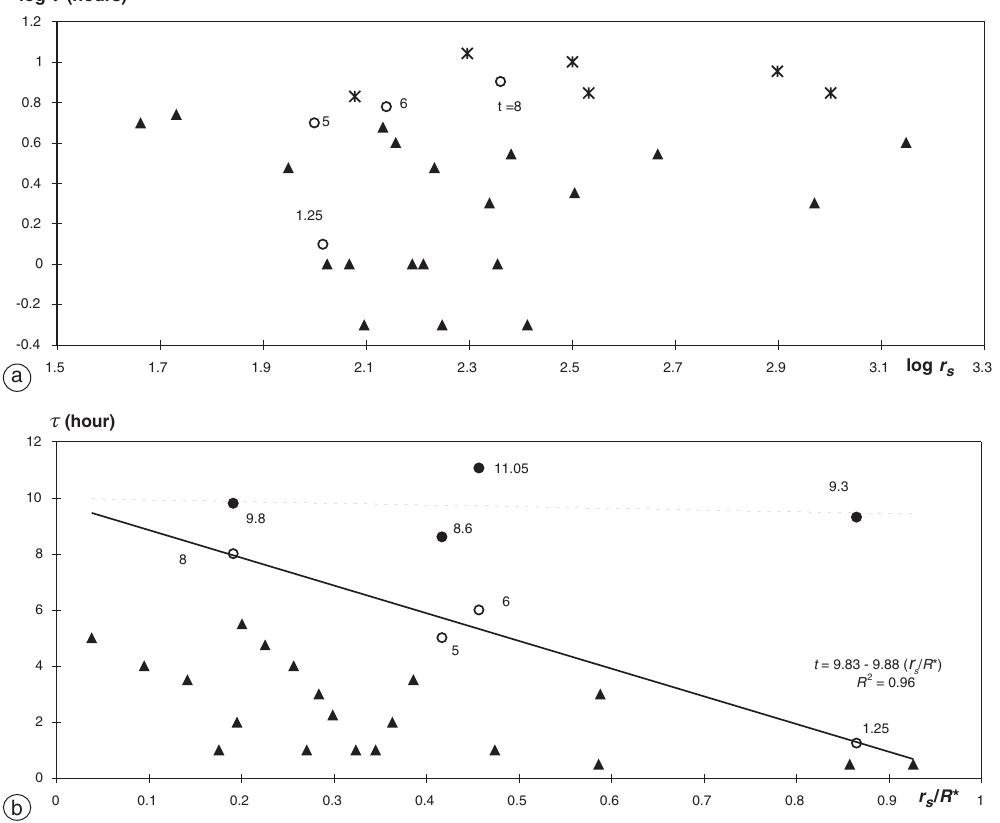
Fig. 5a,b. a) Time of the electrical resistivity precursor (log τ ) versus the logarithm of the hypocentral distance (log r s ) (Rikitake and Yamazaki 1985). The triangles and circles are precursors that continuously developed un- til the earthquake onset ( i.e. «canonical» cases). The stars are precursors that terminated before an earthquake (no. 7, 10, 15, 17, 18, and 26). The circles indicate the events with τ max in terms of the normalized distance r s / R * . The numbers near circles indicate the duration of the precursors in hours. b) Duration of a precursor and a fail- ure process in the focal zone as a function of the hypocentral distance normalized to the size of preparation zone R * . The triangles and open circles indicate the «canonical» cases (see table I). Open circles (no. 6, 21, 24, and 29) indicate the events with τ max estimated in terms of the normalized distance r s / R * . Solid circles are duration times of the fracture process in the source calculated from eq. (5.1) for the events with the precursors shown as open